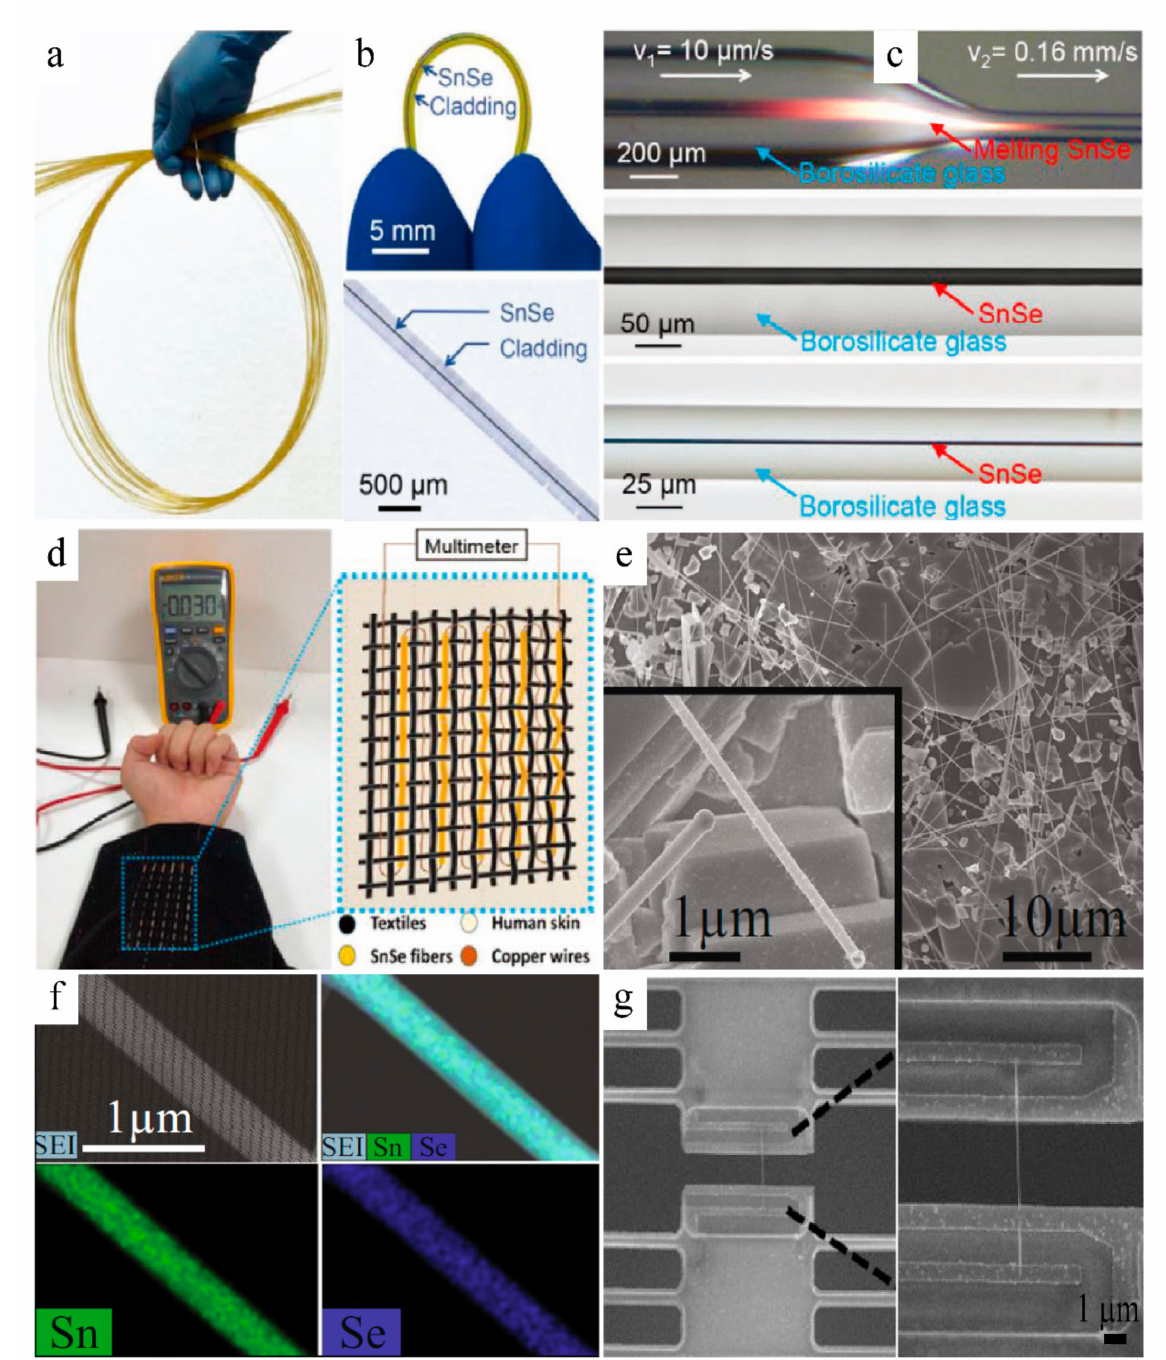
Figure 4. ( a ) Photograph of SnSe fibers. ( b ) Single SnSe fiber and its optical microscope image without polymer coating. ( c